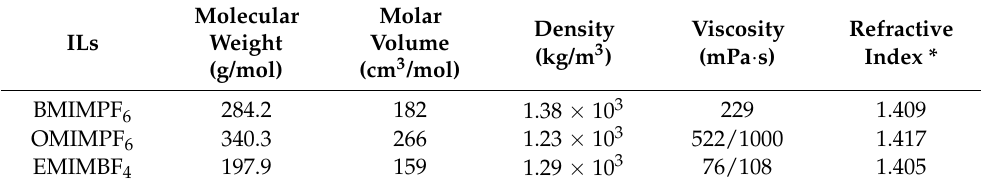
Figure 1. Molecular structure of the protic ionic liquids used in this study (ChemWindow Chemical Structure Drawing Software from Wiley). Table 1. Physicochemical parameters of the selected ILs.